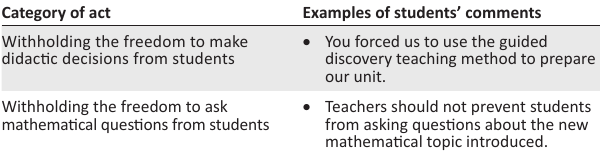
TABLE 4 : Didactic acts lessening freedom.